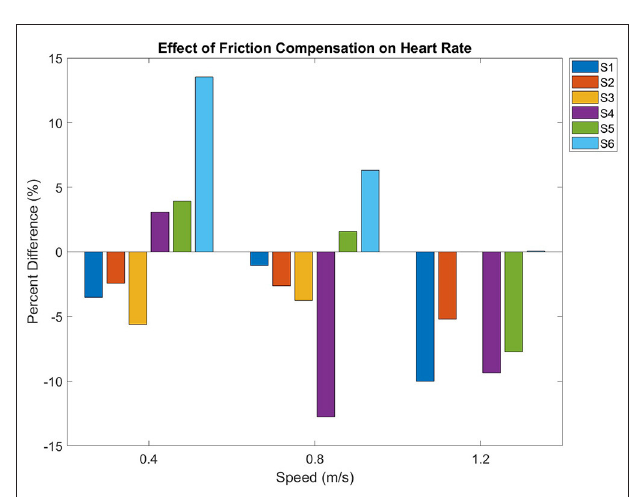
FIGURE 5 | Heart Rate percent difference between uncompensated and friction compensated conditions.